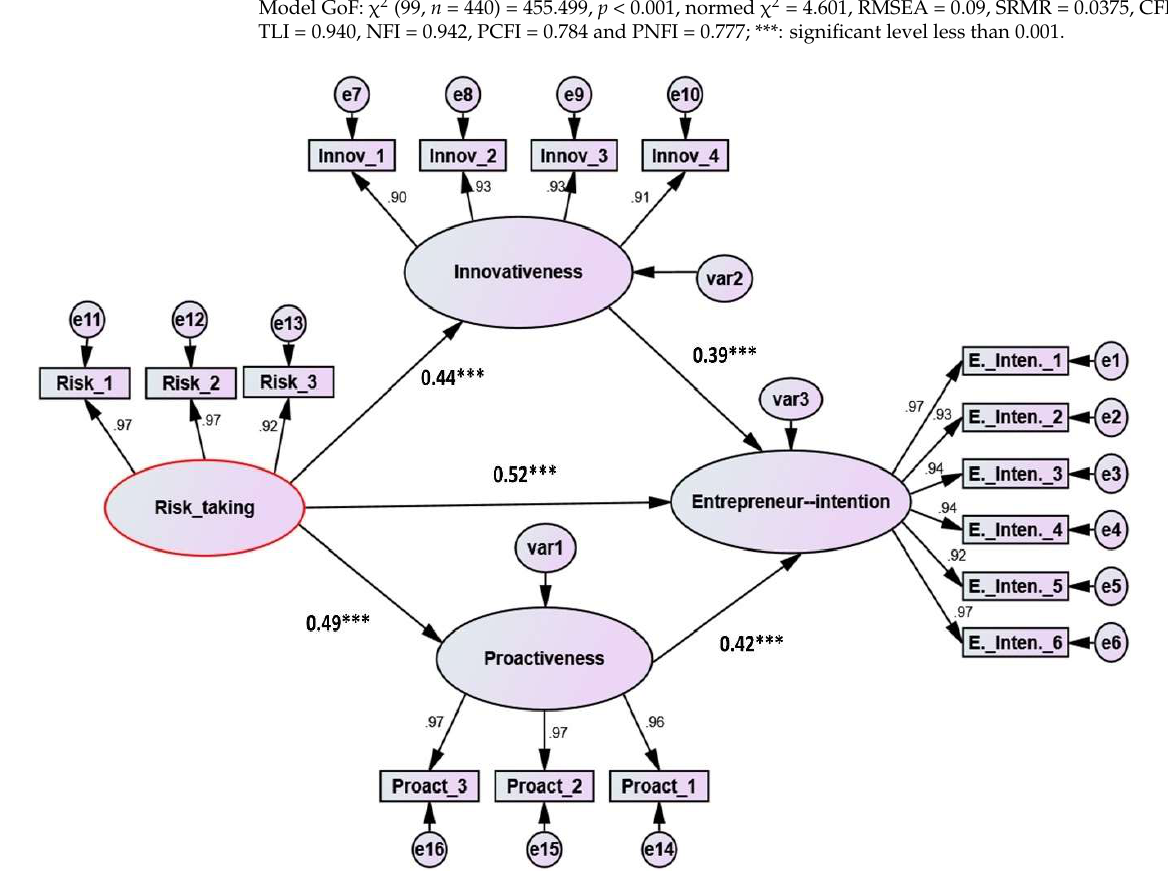
Figure 3. The Study Model. Note: ***: significant level below 0.001. Table 3. The structural model’s results.